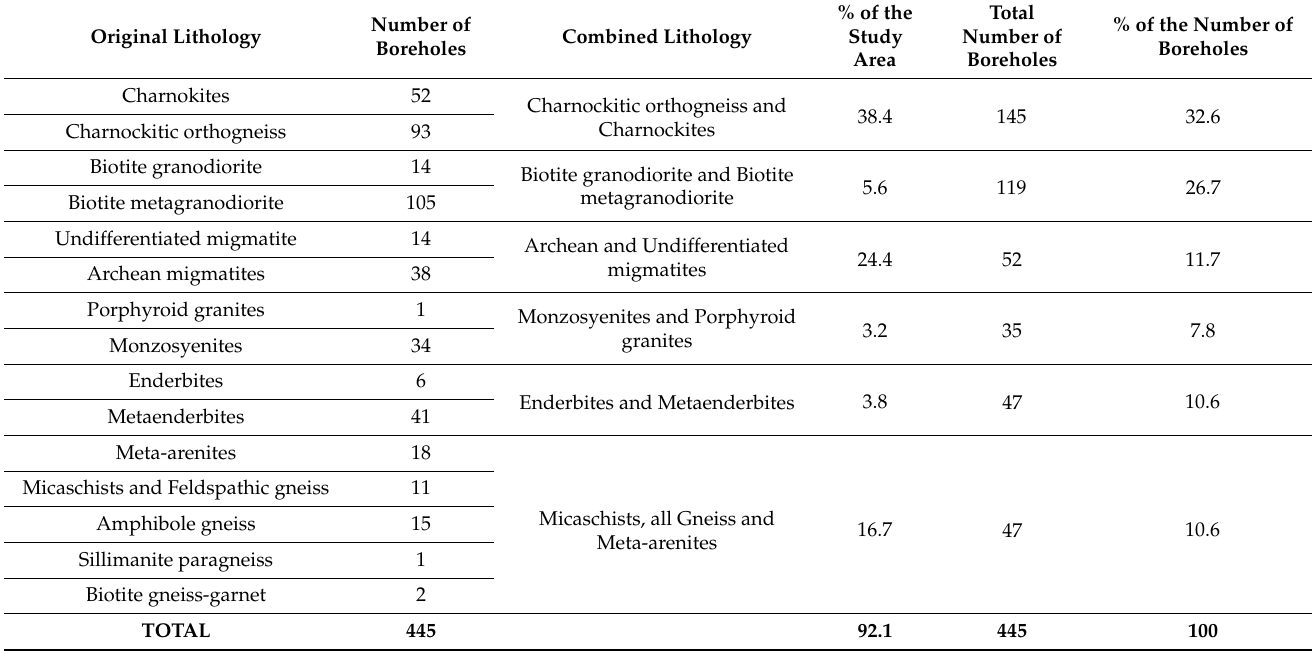
Table 5. Grouping of lithological units and number of associated